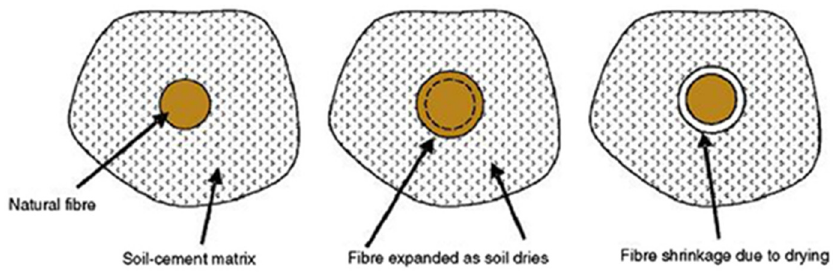
Figure 13. Fibers swelling and shrinkage in sediments matrix (Hejazi et al. 2012).